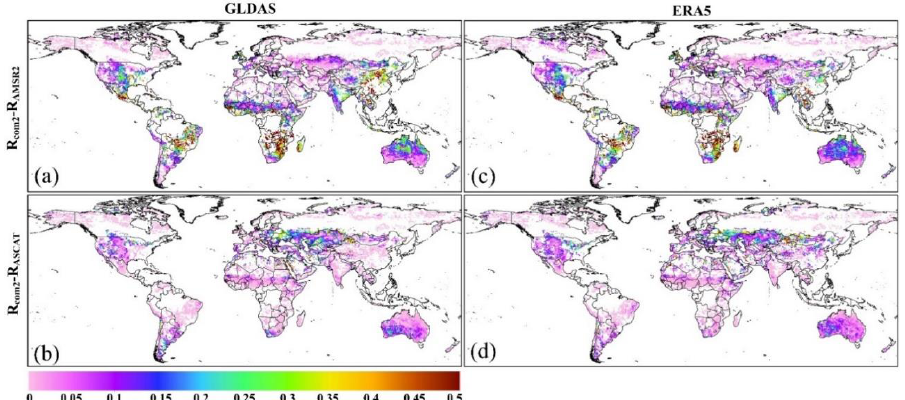
Figure 10. The spatial distribution of differences in correlation coefficients against modeling datasets between merged (AMSR2+ASCAT) and parent (AMSR2 and ASCAT) SM datasets, where (Rcom2 minus RAMSR2) (first row), (Rcom2 minus RASCAT) (second row): ( a , b ) for GLDAS and ( c , d ) for ERA5. Note that, com2 refers to the AMSR2+ASCAT dataset.